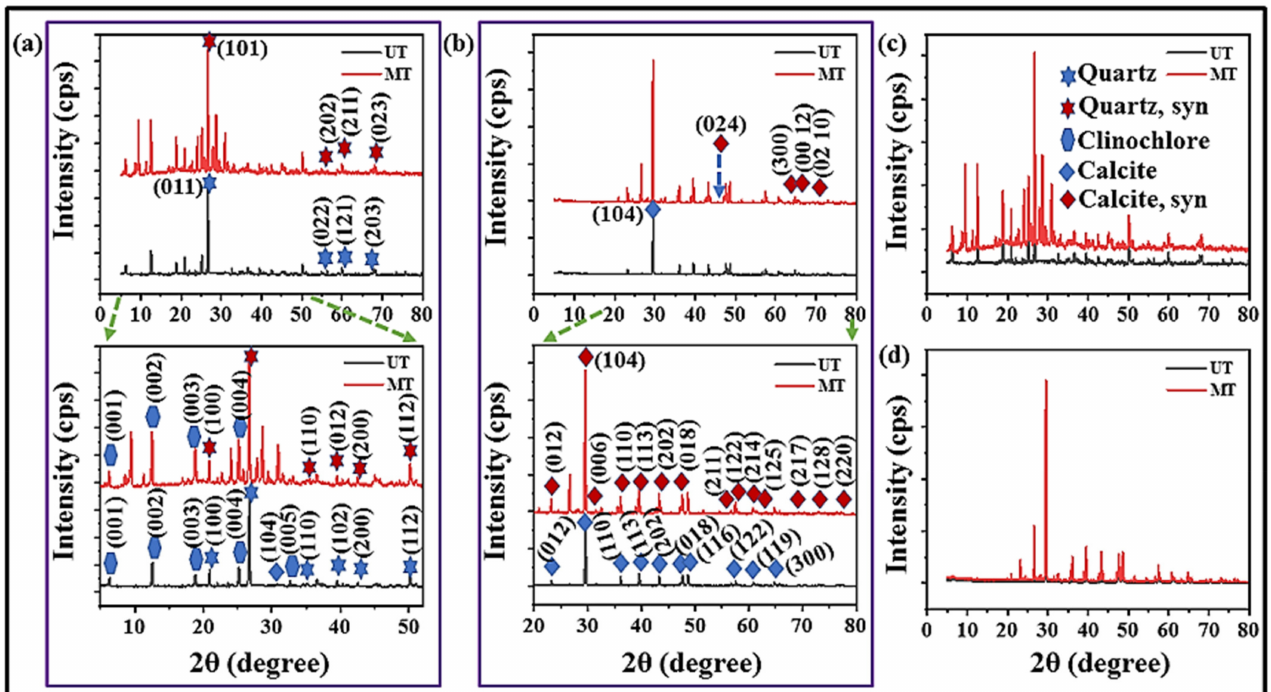
Figure 5. XRD results of the untreated and microwave-treated (2.45 GHz, 1.7 kW, 4 min) representative samples ( a ) S1 and ( b ) S2; ( c ) comparison of the peak intensities of untreated and microwave-treated S1; ( d ) comparison of the peak intensities of untreated and microwave-treated